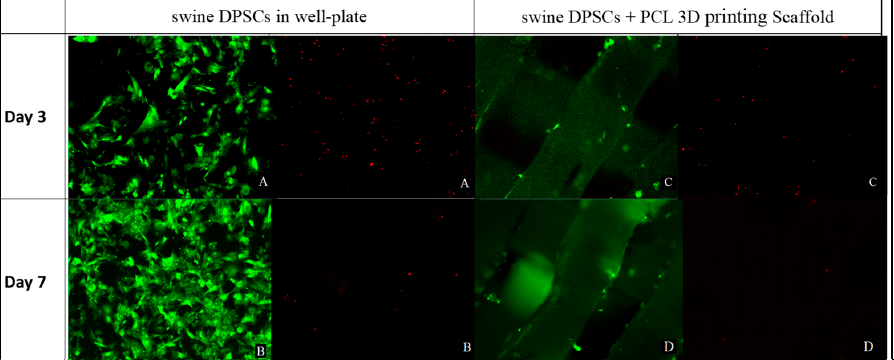
Figure 4. Cell viability and proliferation of swine DPSCs on the covers round objects on 24-well plates ( A , B ) and PCL 3D printed scaffolds ( C , D ). Cell viability and proliferation was determined by live/dead cell assay using calcein- AM (live in green) and ethidium homodimer-1 (dead in red). The results of the Live/Dead staining assay showed a higher proportion of live than dead cells on PCL 3D printed scaffolds than on the control. All images 40 × .